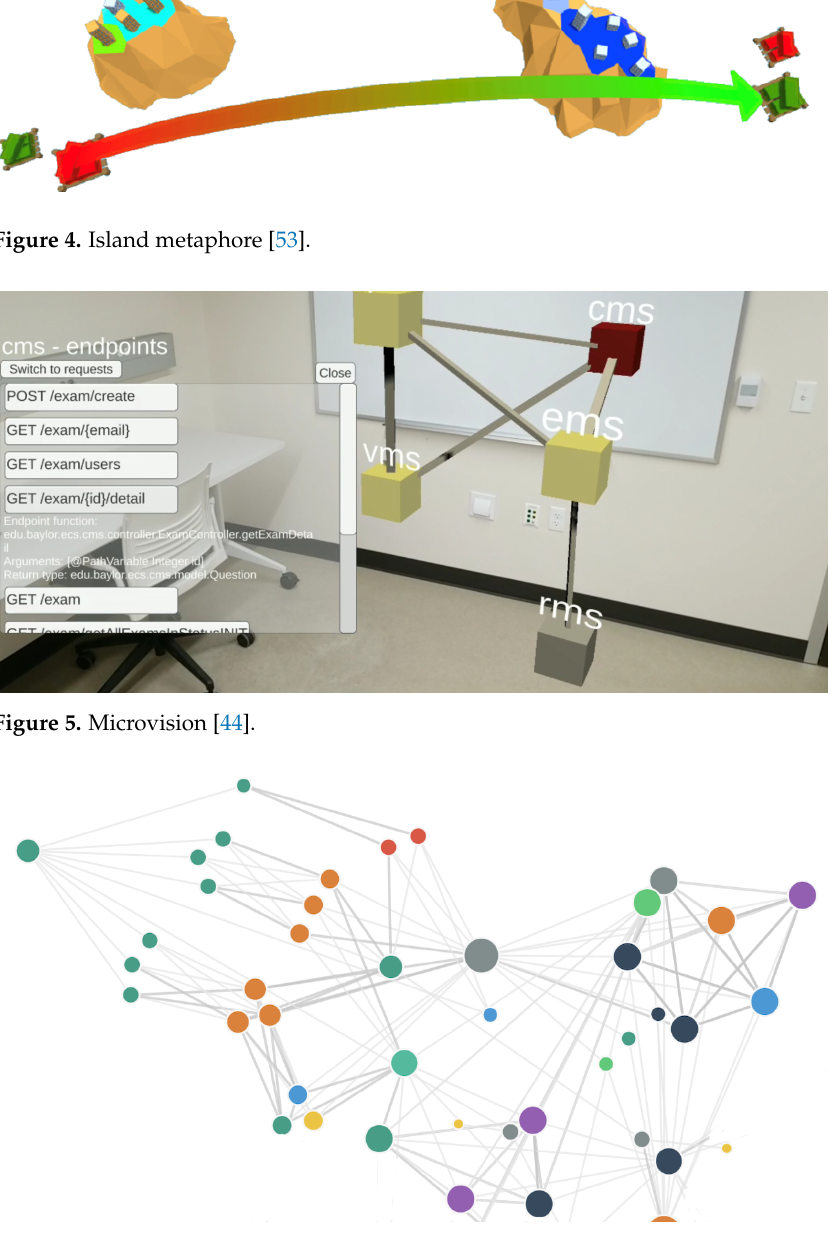
Figure 6. Netflix SDG visualization (https://simianviz.surge.sh/netflix accessed on 1 January